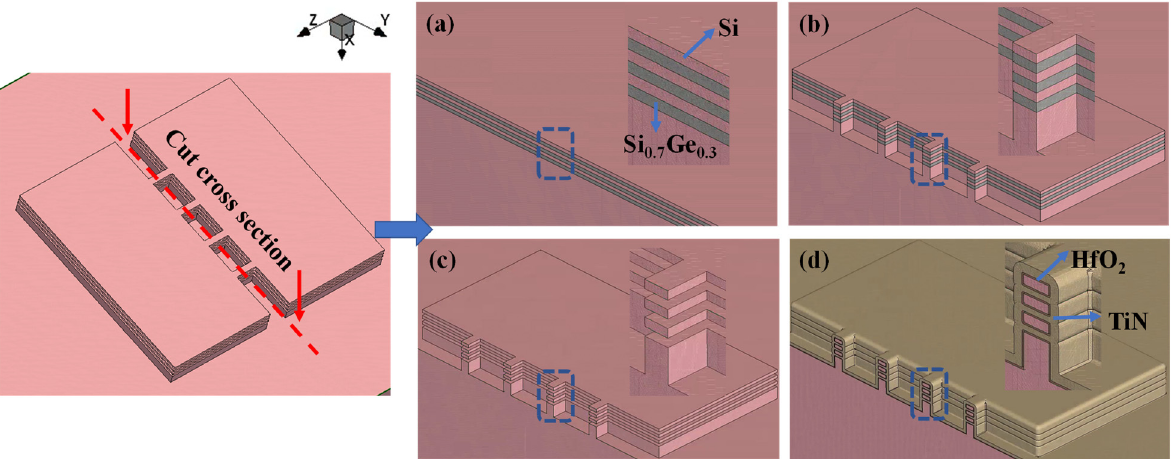
Figure 1. Cross-section of key fabrication steps of GAA Si nanosheet fabrication: ( a ) Multilayer epitaxy of Si/SiGe superlattice. ( b ) S/D and channel patterning. ( c ) Channel release of Si nanosheets. ( d ) HKMG deposition.